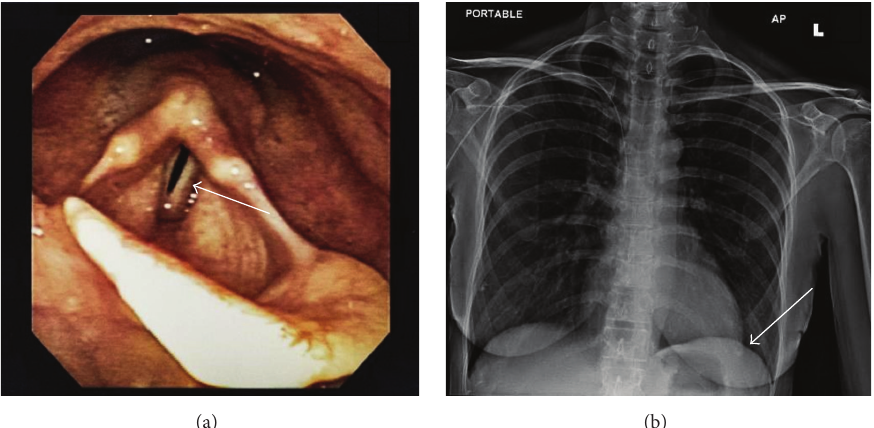
Figure 2: (a) Laryngoscopy photograph of the vocal folds, demonstrating left vocal fold paresis. (b) Portable chest radiograph with elevation of the left hemidiaphragm